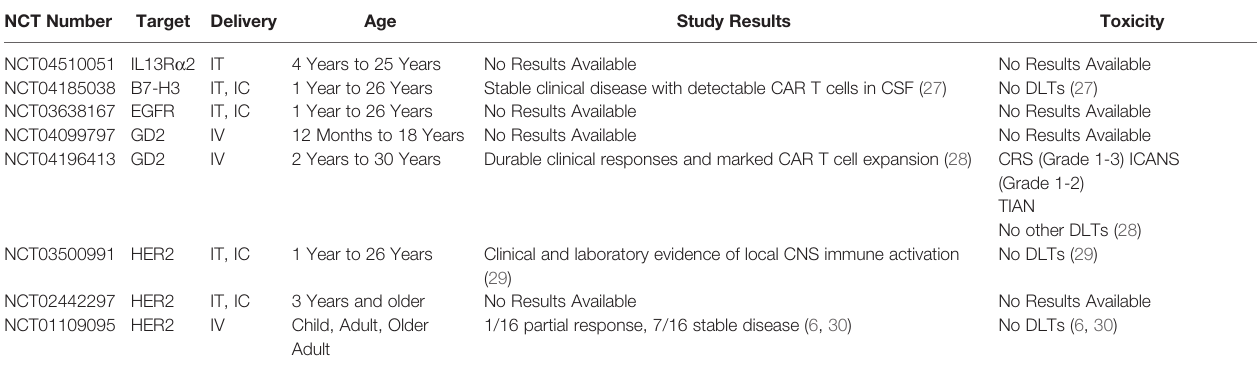
TABLE 1 | Summary of ongoing clinical studies with CAR T cells for